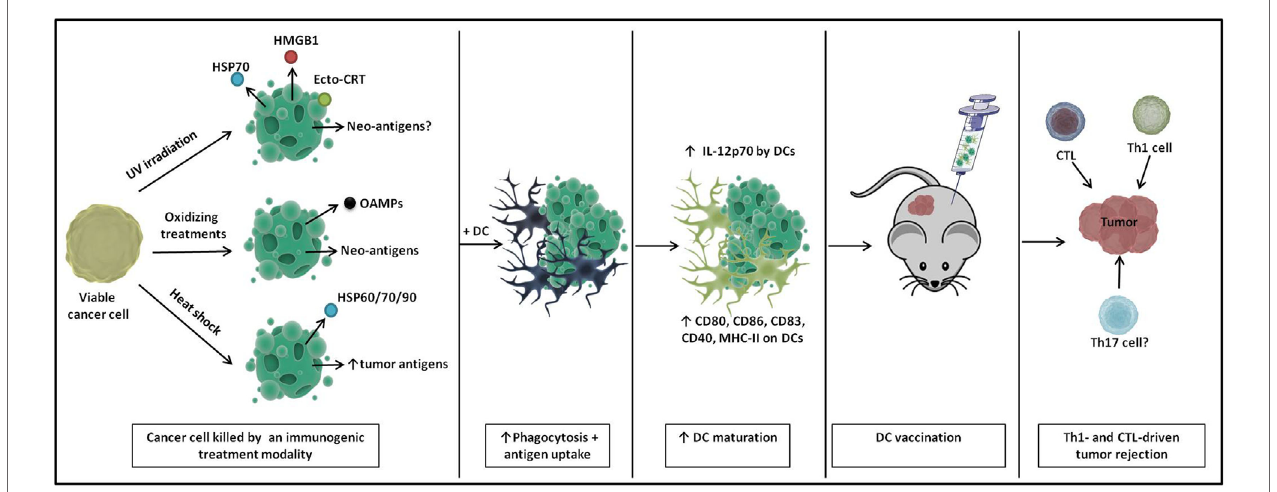
FiGURe 1 | A schematic representation of immunogenic DC vaccines. Cancer cells show enhanced immunogenicity upon treatment with UV irradiation, oxidizing treaments, and heat shock, characterized by the release of particular danger signals and the (increased) production of tumor (neo-)antigens. Upon loading onto DCs, DCs undergo enhanced phagocytosis and antigen uptake and show phenotypic and partial functional maturation. Upon in vivo immunization, these DC vaccines elicit Th1- and cytotoxic T lymphocyte (CTL)-driven tumor